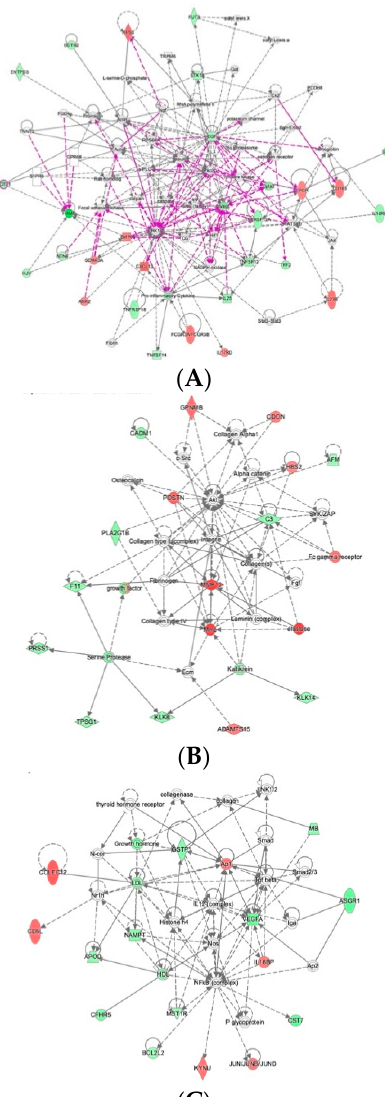
Figure 4. Networks of interacting proteins with expression changes in the preoperative and post- operative states. ( A ). Network of EGF and VEGF proinflammatory interactors. ( B ). Network of MMP12-ECM interactors. ( C ). Network of VEGF, NOS, and NF- κ B signaling. Red indicates upreg- ulation and green denotes downregulation in ‘post’. Proteins are coded by shape; square—cyto- kine, vertical rhombus—enzyme, horizontal rhombus—peptidase, trapezoid—transporter, el- lipse—transmembrane receptor, and circle—other.